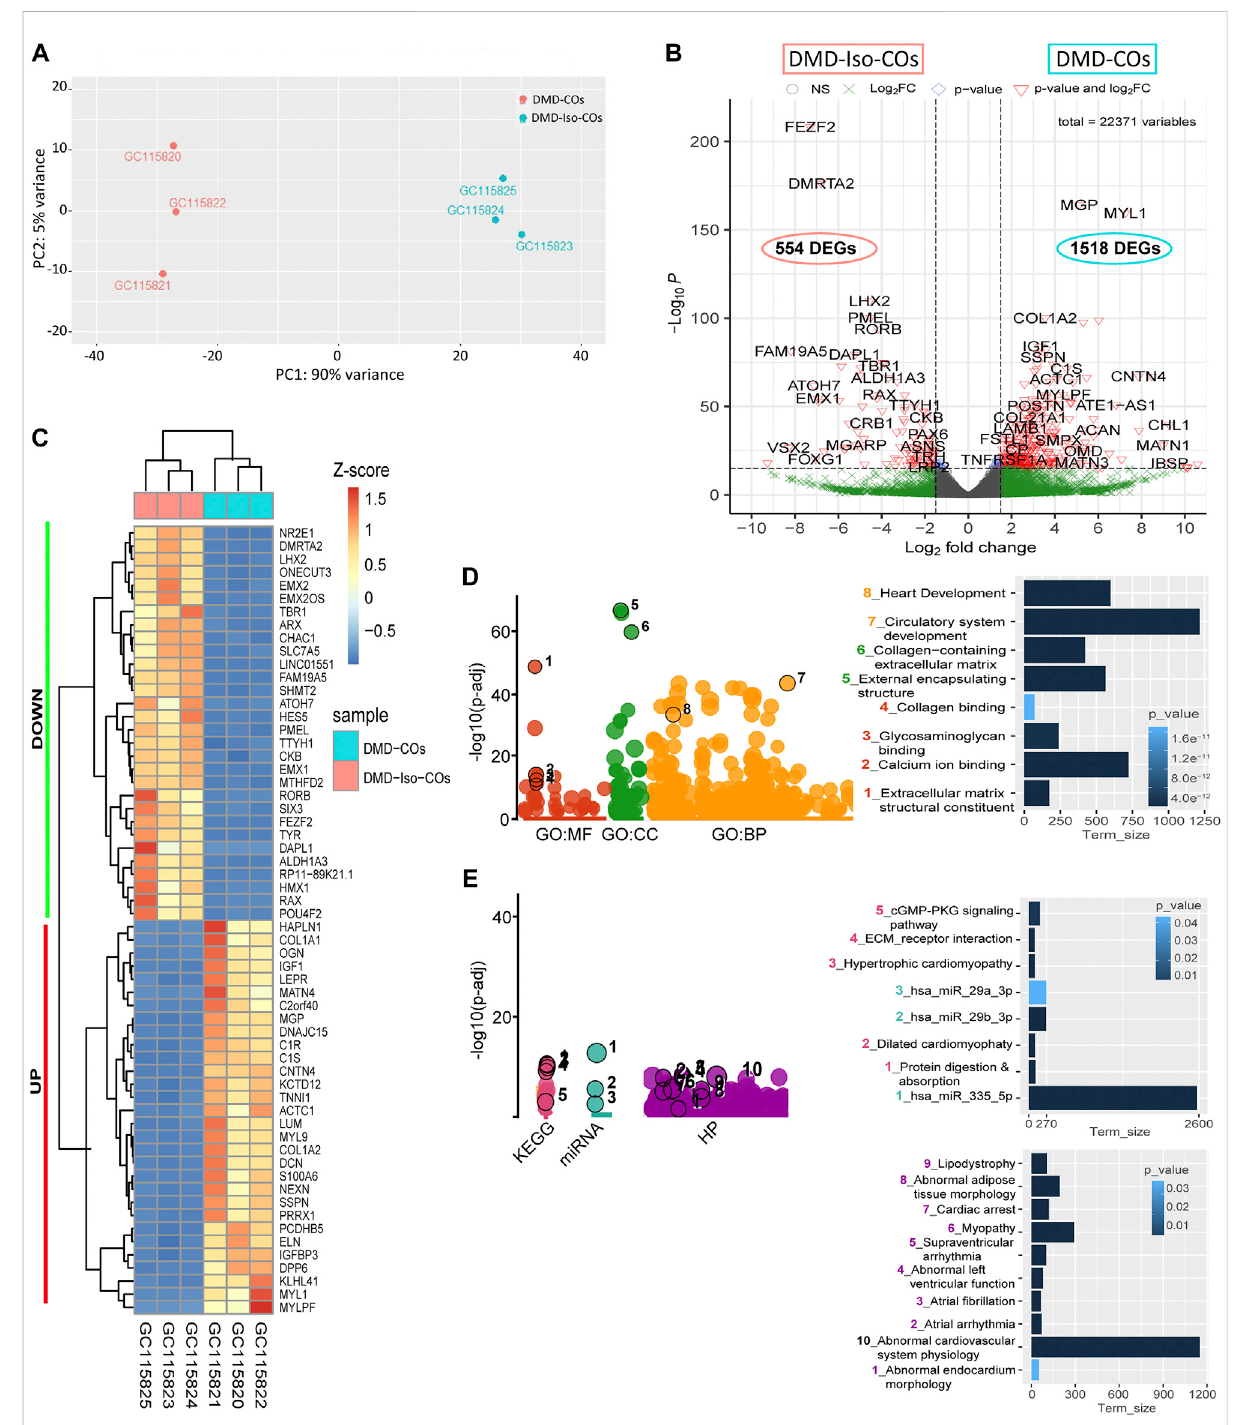
FIGURE 6 RNA sequencing analysis of DMD-COs and DMD-Iso-COs via DESeq2 method. (A) Principal component analysis (PCA) showing distinct separation of the DMD-COs and DMD-Iso-COs clusters (PC1: 90%) with low intra-condition variance (PC2: 5%) in both conditions, respectively. (B) Enhanced volcano plot showing the differentially expressed genes (DEGs) in DMD-COs versus DMD-Iso-COs. Cut-off log 2 fold change = 1.5; Cut- off − Log 10 p = 10 – 16 . (C) Heatmap showing the TOP30 DEGs in DMD-COs versus DMD-Iso-COs. (D , E) Functional enrichment analysis of the differentially upregulated genes in DMD-COs versus DMD-Iso-COs using gPro fi ler2 for Gene ontology, KEGG pathway, miRNA and human phenotype ontology. (All data shown: n = 3, each sample was a pooled of ~10 organoids).